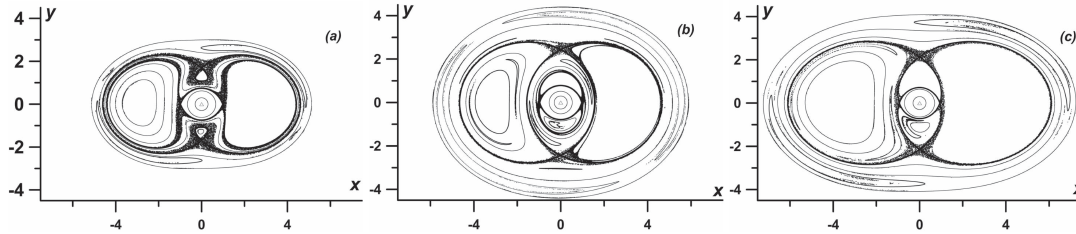
Figure 7. Poincaré maps for the perturbed the system in Equation (49) (perturbation magnitude ε = 0.01, and frequency ν = 0.0145) corresponding to the steady-state phase portraits shown in Figure 5: ( a ) 1.2; ( b ) 2.1; and ( c ) 1.1.